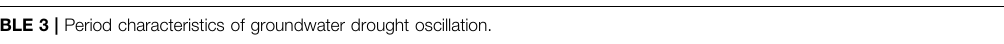
TABLE 3 | Period characteristics of groundwater drought